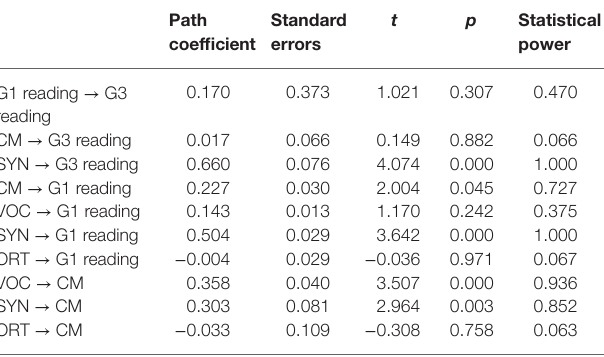
TABLE 3 | Direct effects of model predictors in the longitudinal